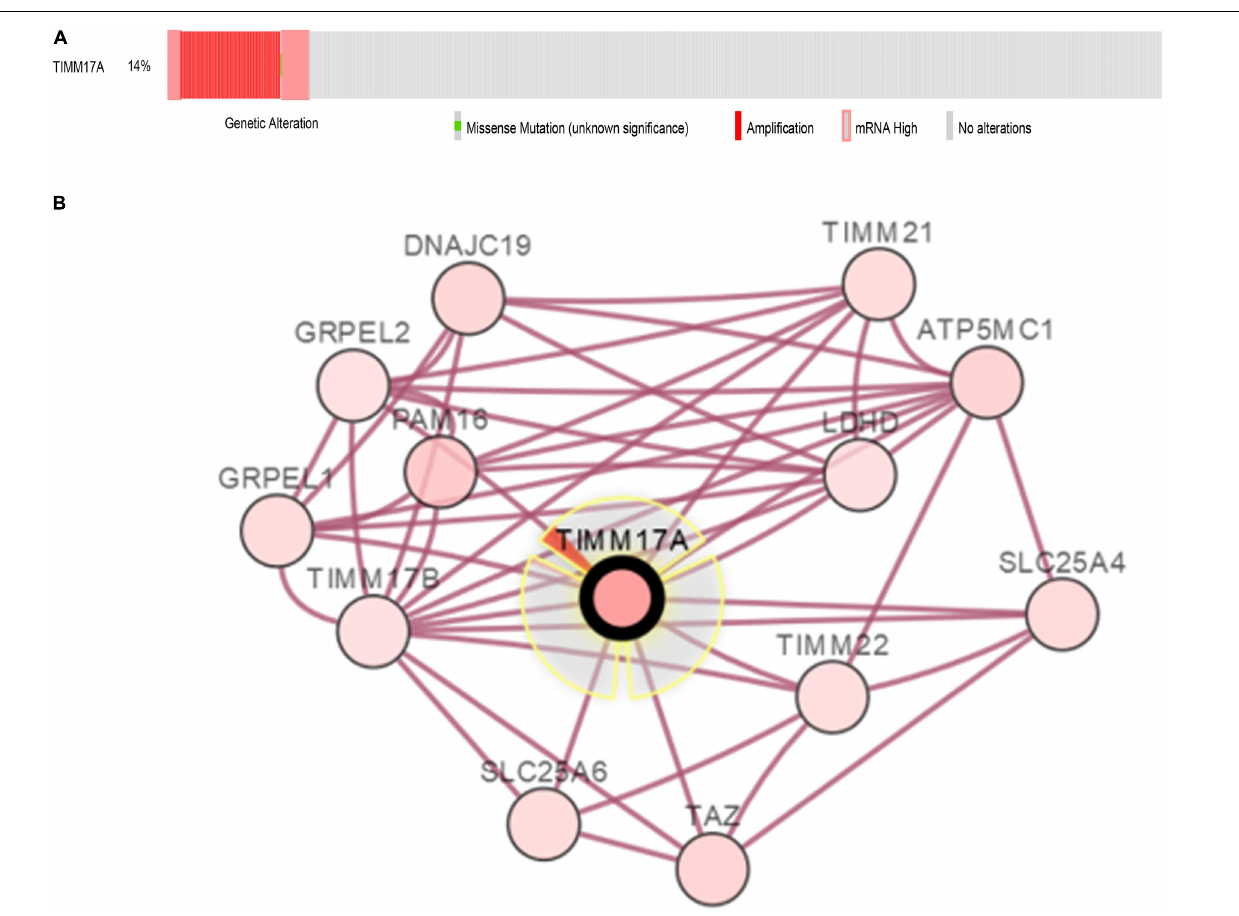
FIGURE 4 | Visual summary of TIMM17A alterations and biological interaction networks in breast carcinoma (cBioPortal). (A) OncoPrint of TIMM17A alterations in BRCA. The OncoPrint provides an overview of genomic alterations in TIMM17A affecting individual samples (columns) in BRCA from the TCGA dataset. The different types of genetic alterations are indicated by unique colors. (B) Network view of the TIMM17A neighborhood in BRCA. TIMM17A is the seed gene (indicated with thick border), and all other genes altered in BRCA are automatically identified Darker red indicates increased alteration frequency in BRCA. The interaction types are derived from the Biological Pathway Ex-change (BioPAX). The red connection indicates proteins are members of the same